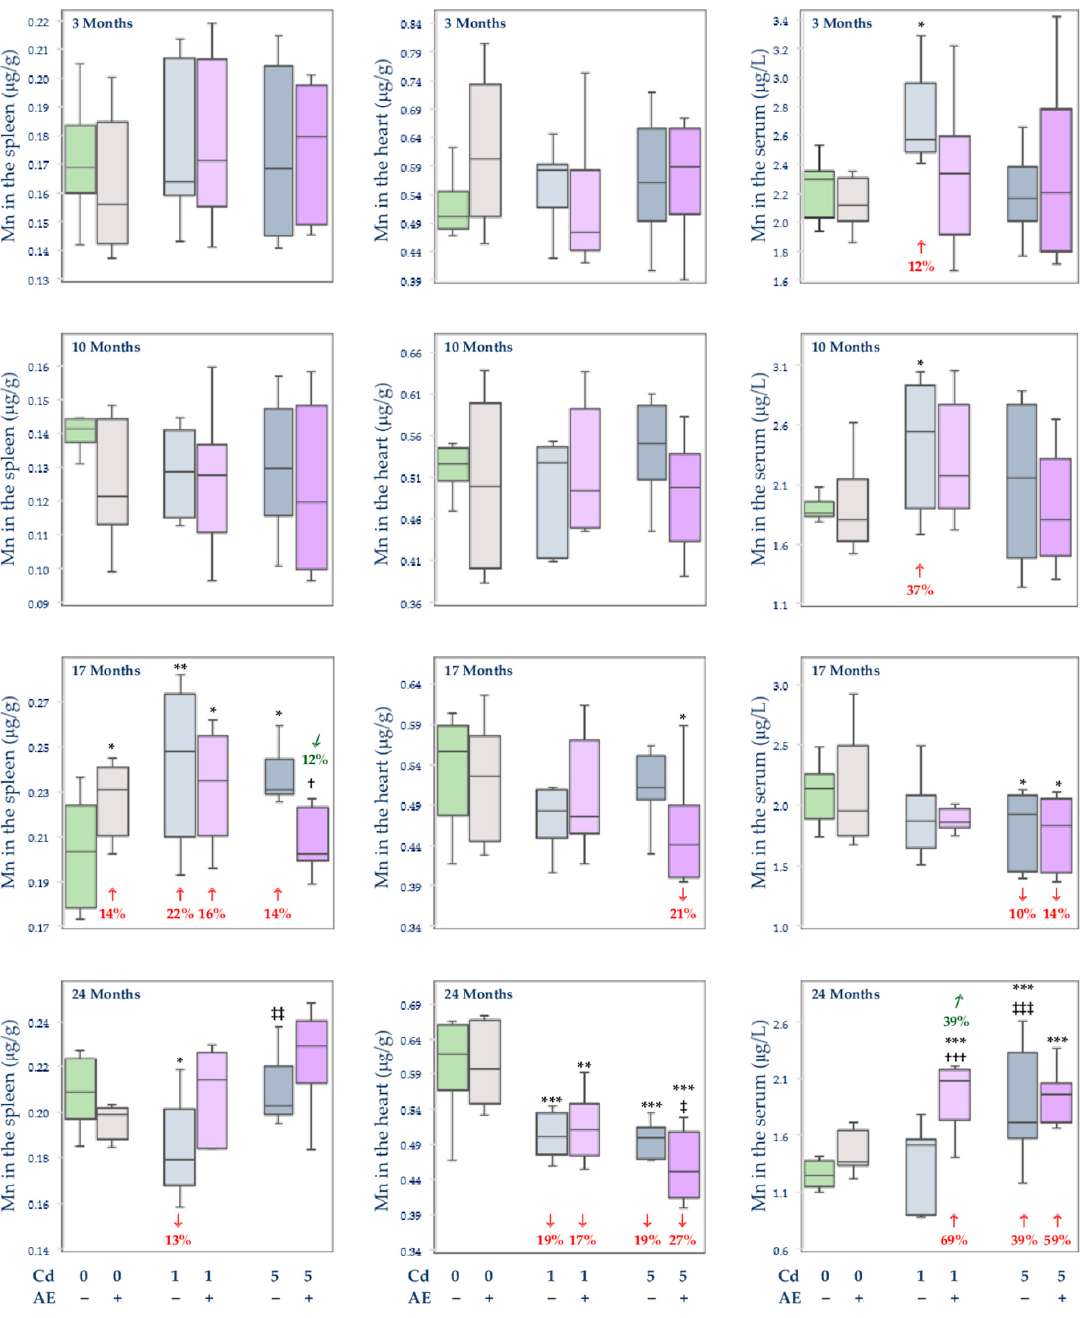
Figure 5. The concentration of Mn in the spleen, heart, and serum in particular experimental groups. The rats received Cd in the diet at the concentration of 0, 1, and 5 mg/kg and/or 0.1% AE as the only drinking fluid (“+”, administered; “ − ”, without administration). Data represent a median and 25–75% confidence interval (the horizontal lines within the bars presenting the confidence interval represent median values), as well as the minimum and maximum values for eight rats in each experimental group (except for seven animals in the AE, Cd1, and Cd5 groups after 24 months). Statistically significant differences: * p < 0.05, ** p < 0.01, *** p < 0.001 vs. control group; † p < 0.05, ††† p < 0.001 vs. respective group receiving Cd alone (Cd1 or Cd5 group); ‡ p < 0.05, ‡‡ p < 0.01, ‡‡‡ p < 0.001 vs. respective group receiving the 1 mg Cd/kg diet alone (Cd1 group) or with the AE (Cd1 + AE group) are marked. The values below and above the bars indicate percentage changes compared to the control group ( ↓ , decrease; ↑ , increase) or the respective group receiving Cd alone ( increase),